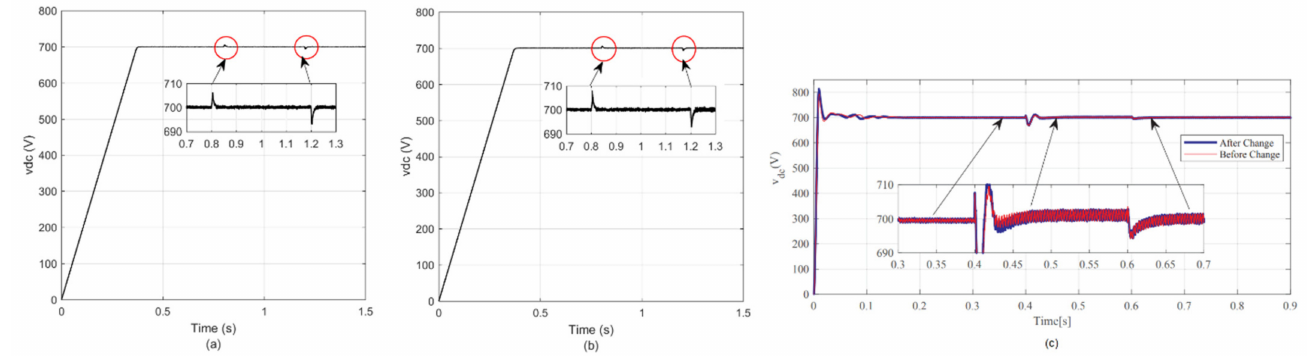
Figure 8. The DC-link voltage under two different sets of hybrid MG parameters, ( a ) under the first set, ( b ) under the second set, ( c ) under two different sets of MG parameters in ref [19].